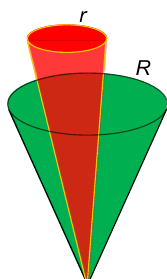
Figure 1 . Illustration of a subjet with radius r (red) inside a jet with a radius R (green). We focus on describing the energy fraction z r of the jet that is carried by the